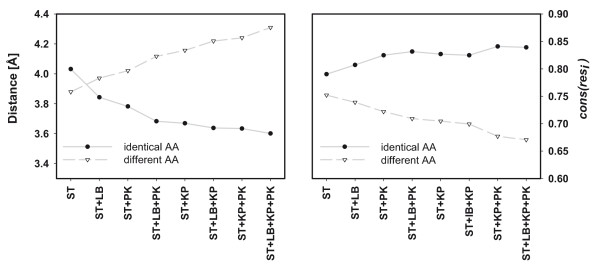
Dependence of distance to the ligand and residue conservation for recapitulated and not recapitulated residues on TransCent's configuration. Different combinations of modules were used to generate 20 models each in a recapitulation experiment for all enzymes belonging to ENZ_TESThom. All residues resi ϵACT_CENT were analyzed. The left panel depicts the mean distance of their Cβ-atoms (Cα in case of Gly) to the nearest atom of the ligand. The right panel depicts the mean conservation as deduced from the respective columns of the MSA and as expressed by the score cons(resi). For the models, residues were grouped: "identical AA" are those residues possessing the same amino acid as the templates, "different AA" are those ones, where TransCent proposed a different amino acid. Abbreviations for modules are: ST (stability), LB (ligand binding), KP (knowledge-based potential) and PK (pKa values).